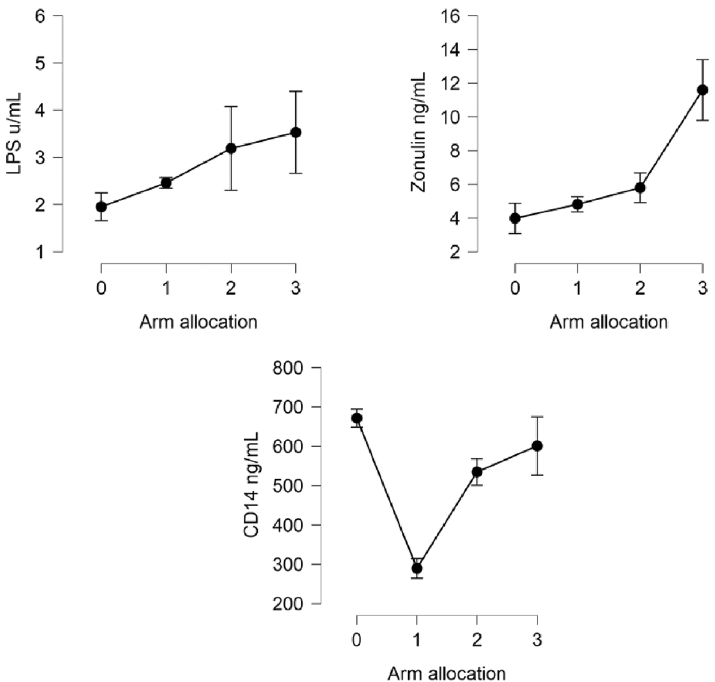
Figure 3. Descriptive plots based on arm allocation. Data are reported as mean and standard error. 0: primaries; 1: aseptic revisions; 2: Chronic PJI; 3:acute